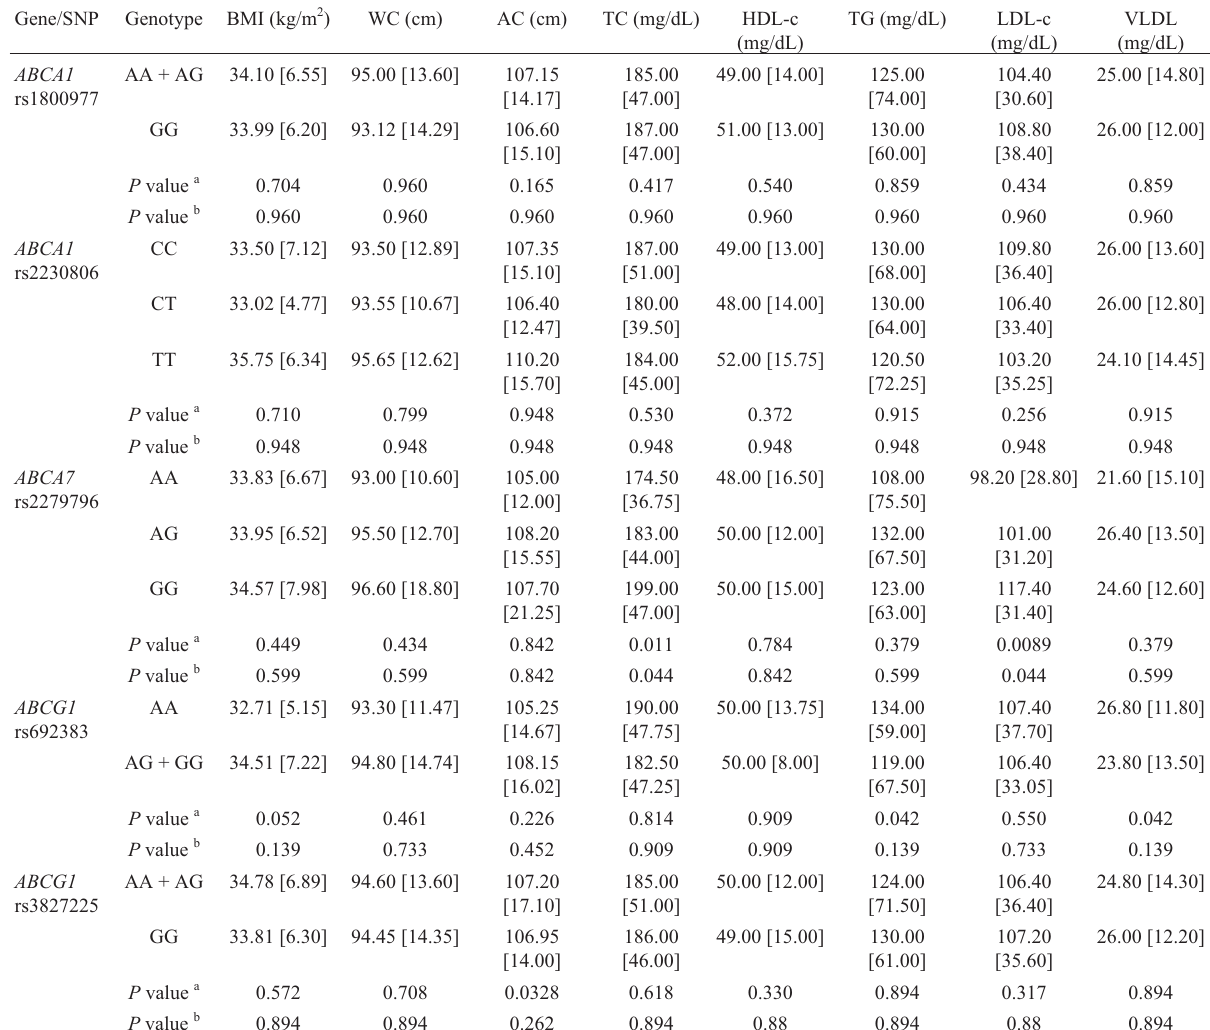
Table 3 - Baseline characteristics (median [IQR]) according to the ABCA1 , ABCA7 and ABCG1